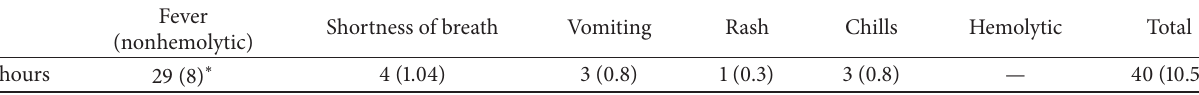
Table 2: Blood transfusion’s reactions 𝑛 (%) (out of 382 blood units).